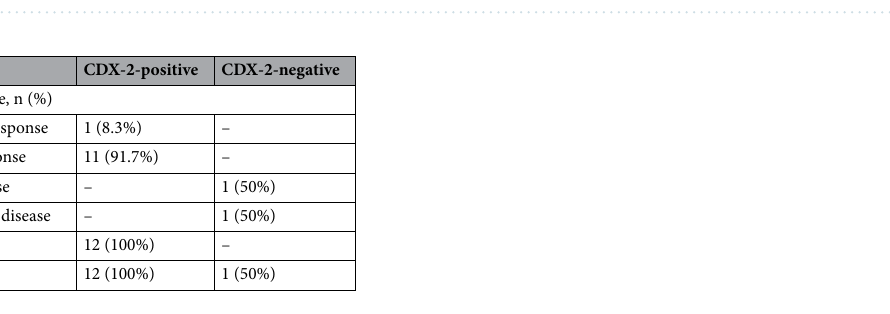
Table 2. Response rate. ORR: overall response rate; DCR: disease control